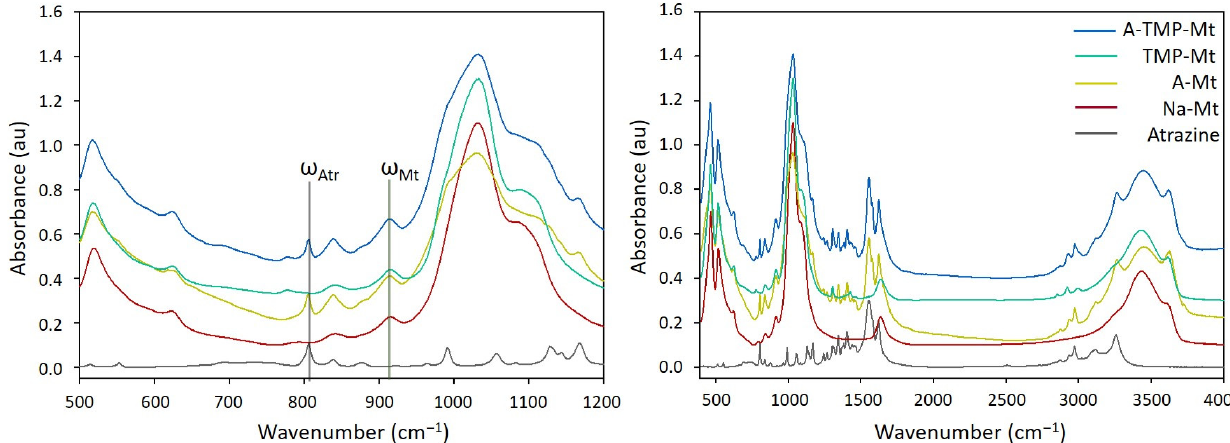
Figure 15. Comparison of the FTIR spectra for atrazine, pure montmorillonite (Na-Mt) and modified montmorillonite samples (A-Mt, TMP-Mt and A-TMP-Mt). For clarity, the spectra are consecutively shifted with respect to 0.0 au baseline and the spectrum of atrazine is scaled by a factor 0.3: (Left) spectra in the range 500–1200 cm − 1 ; and (right) complete spectra in the range 500–4000 cm − 1 .